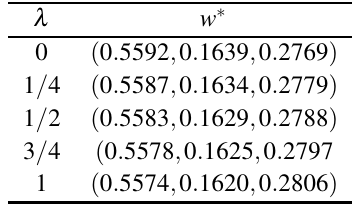
Table 4. Changes in priority vector and satisfaction with respect to parameter λ